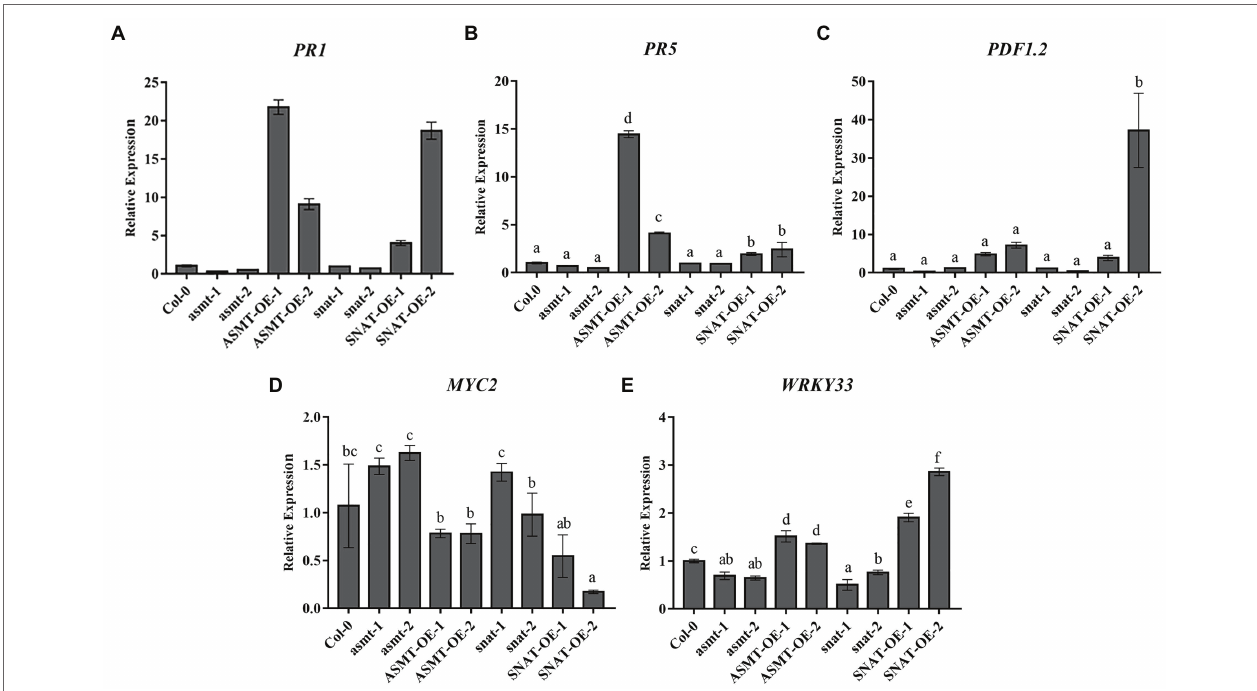
FIGURE 1 | Expression of defends signaling-related gene following Botrytis cinerea treatment. The transcript levels of PR1 (A) , PR5 (B) , PDF1.2 (C) , MYC2 (D) , and (E) WRKY33 were determined by RealTime Quantitative Polymerase Chain Reaction (RT-qPCR). RNA extracted from rosette leaves of 4-week old wild-type (Col-0), N-acetylserotonin methyltransferase ( ASMT )-overexpressed ( ASMT-OE-1 , ASMT-OE-2 ) plants, serotonin N-acetyltransferase ( SNAT )-overexpressed ( SNAT- OE-1 , SNAT-OE-2 ) plants, snat silencing lines ( snat-1 , snat-2 ), and asmt silencing lines ( asmt-1 , asmt-2 ) at 48 h after the B. cinerea infection. PR1 ( AT2G14610 ), pathogenesis-related protein 1; PR5 ( AT1G75040 ), pathogenesis-related protein 5; PDF1.2 ( AT5G44420 ), plant defensin 1.2; MYC2 ( AT1G32640 ); and WRKY33 ( AT2G38470.1 ). The data (mean ± SD) were calculated using three replicate assays, with the SEs indicated by the vertical bars. Different lowercase letters indicate statistically significant differences ( p <